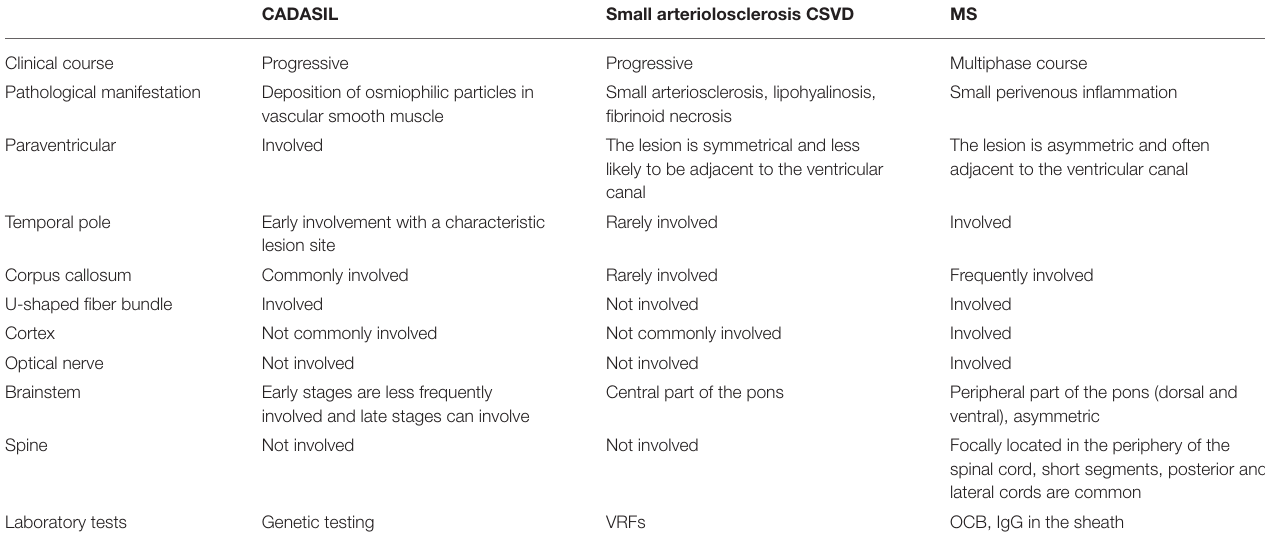
TABLE 1 | Identification and comparison of CADASIL, small arteriolosclerosis CSVD and